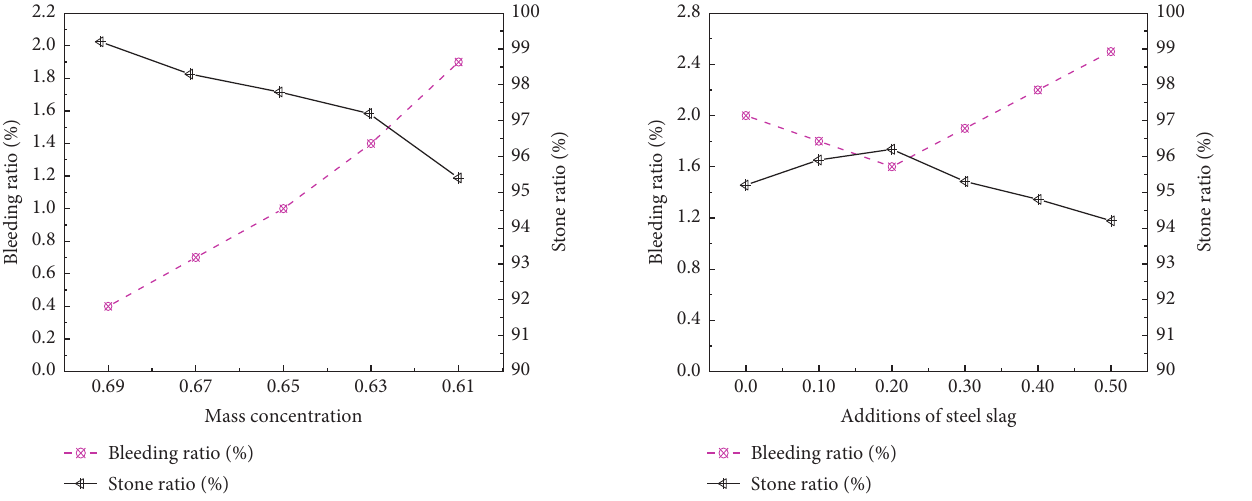
Figure 6: The bleeding ratio and stone ratio of the waste sediment- based grouting material with different mass concentrations of solid components.